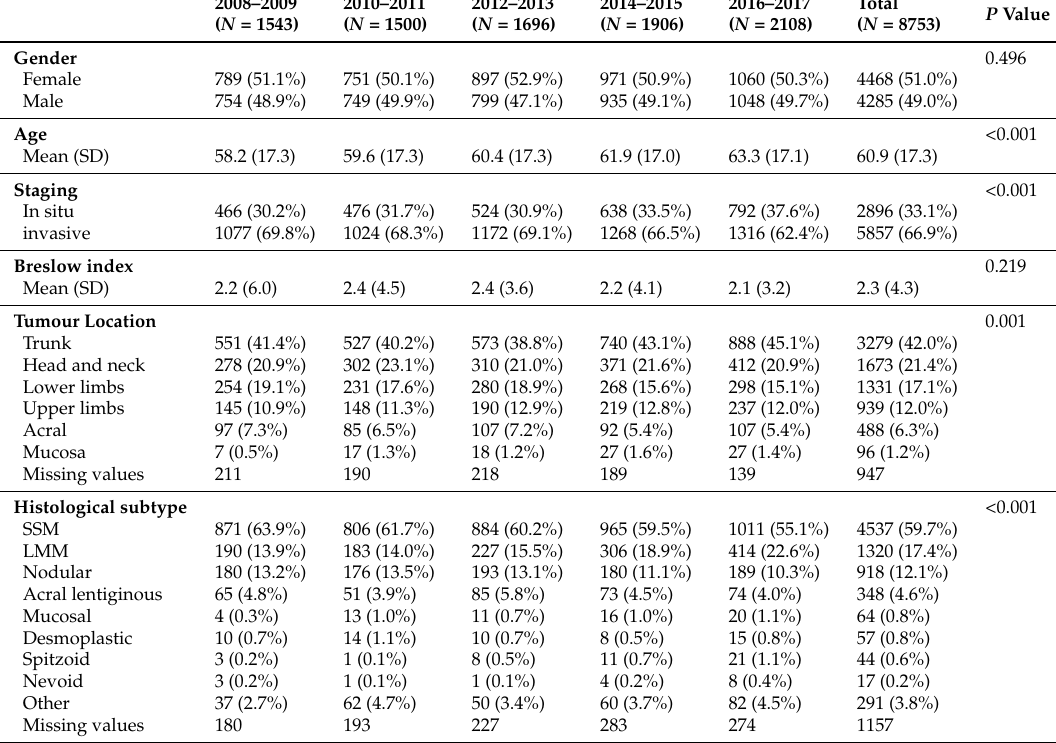
Table 1. Basal characteristics of the tumours.